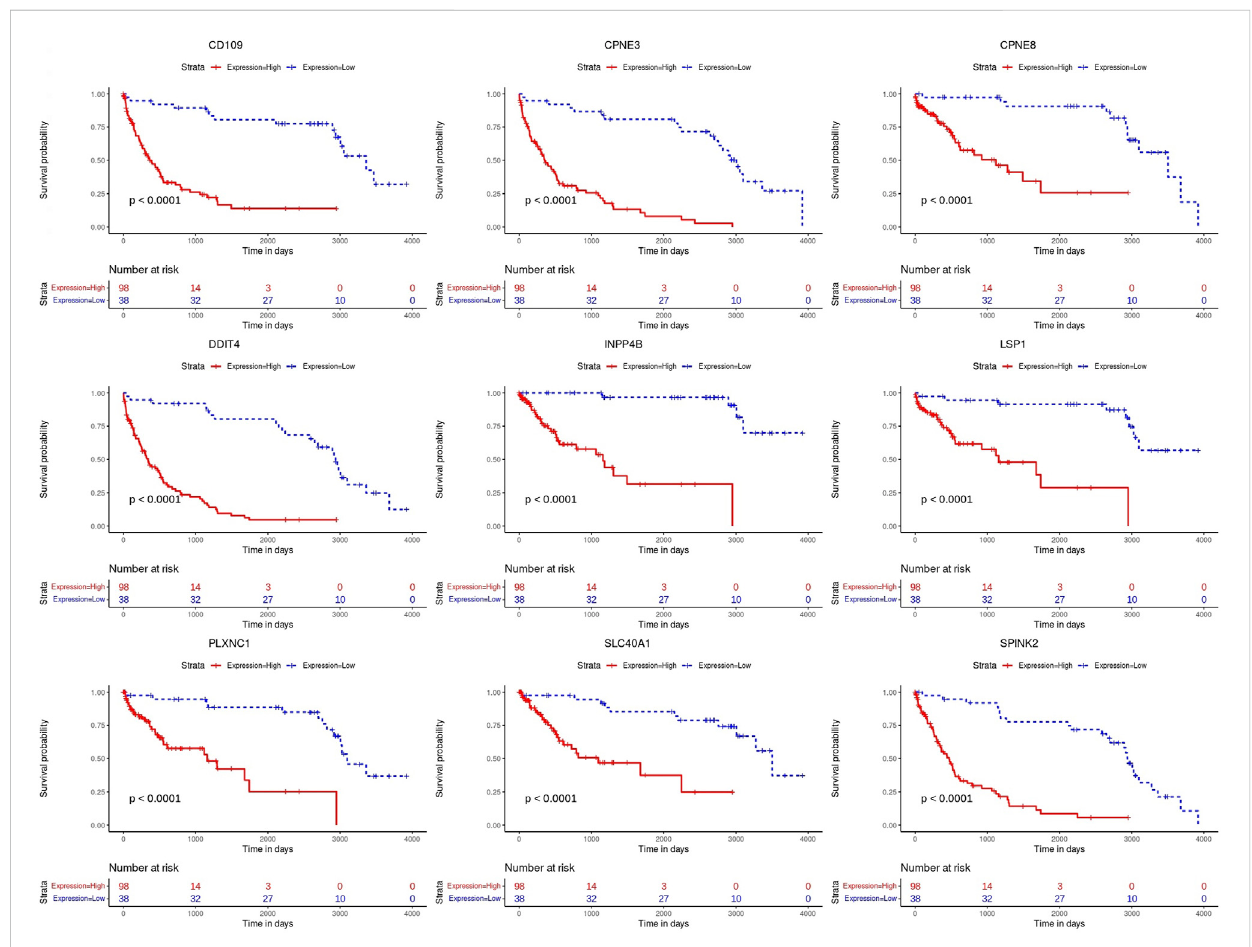
FIGURE 3 Kaplan-Meier (K-M) survival curves. Analysis on the prognostic genes in the validation dataset (GSE37642).